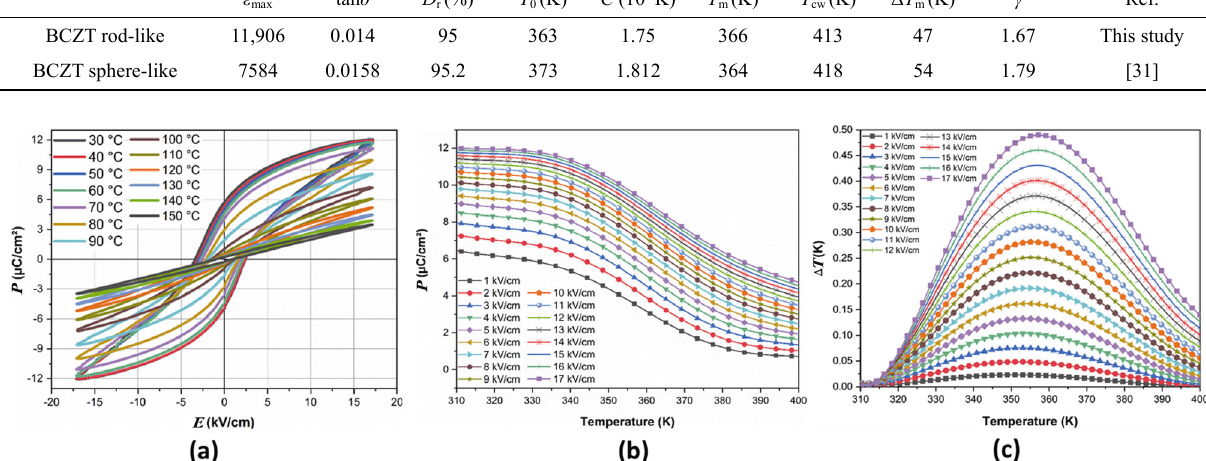
Fig. 5 Temperature-dependence of (a) P – E loops, (b) electric polarization, and (c) the reversible adiabatic electrocaloric temperature change (Δ T) of rod-like BCZT ceramics under various applied electric